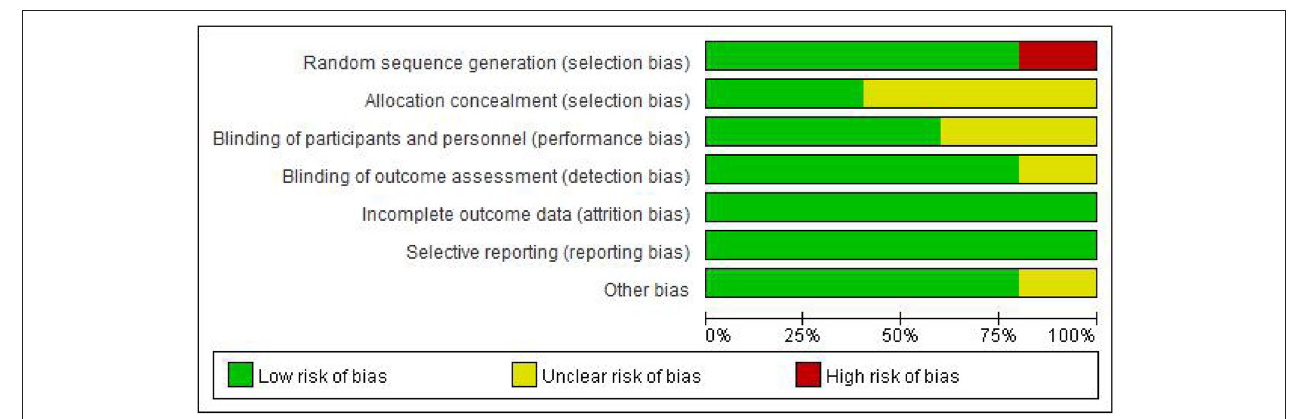
FIGURE 2 | Risk of bias and applicability